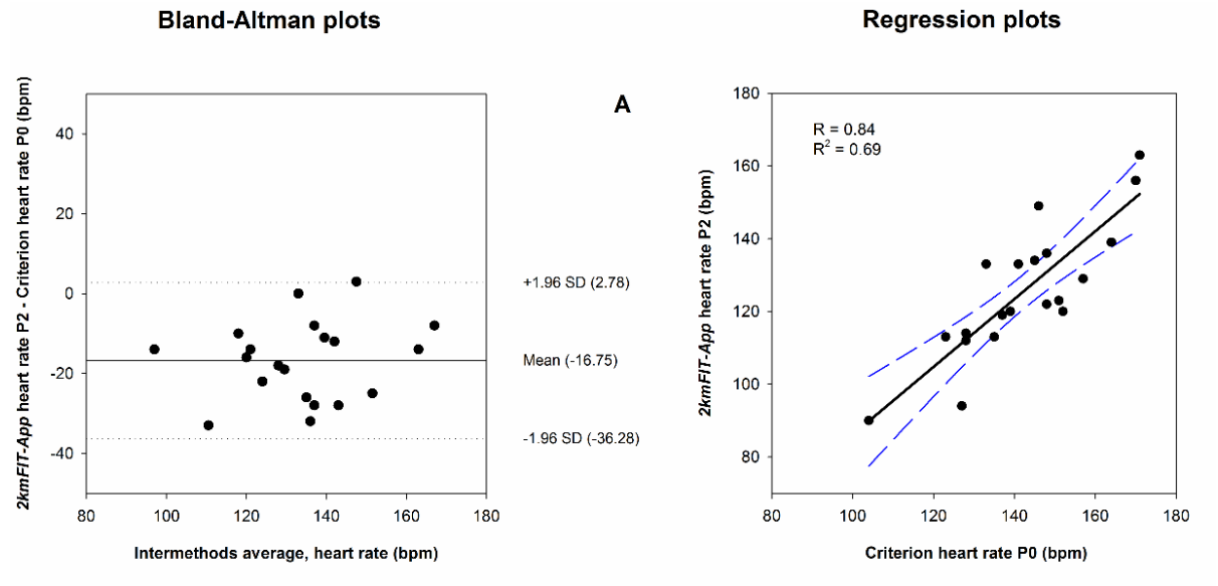
Figure 3. Agreement and regression plots for heart rate as measured by the app (2kmFIT-App, Android version) versus criterion. In the Bland-Altman plot, the central line represents the mean difference (systematic error) and the upper and lower dotted lines represent the 95% limits of agreement (mean difference, SD 1.96 of the differences). Criterion HR P0: polar HR taken immediately when the test finished; R: Pearson correlation coefficient; R2: coefficient of determination; bpm: beats per minute.